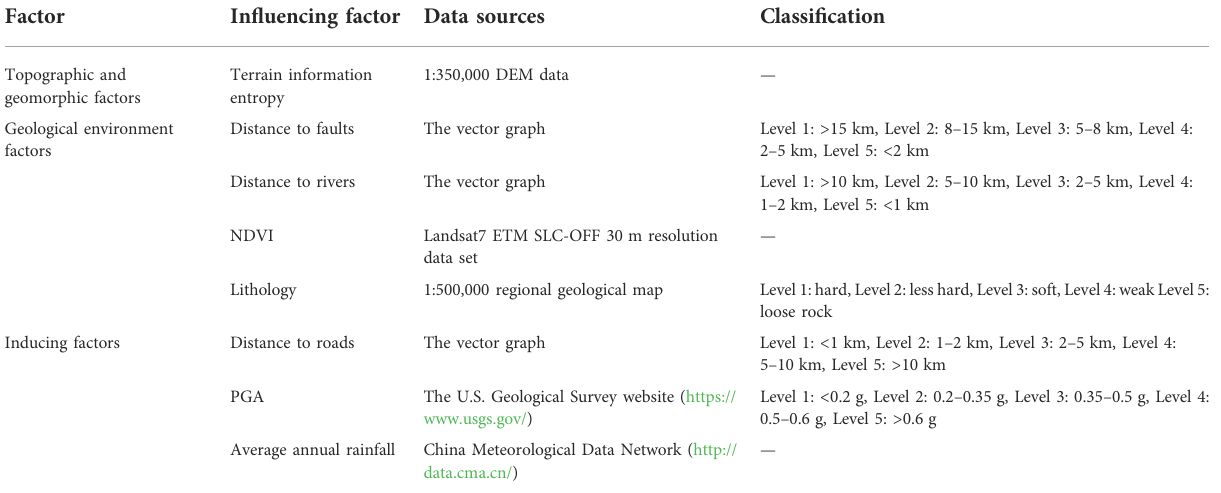
TABLE 1 The speci fi c situation of the in fl uencing